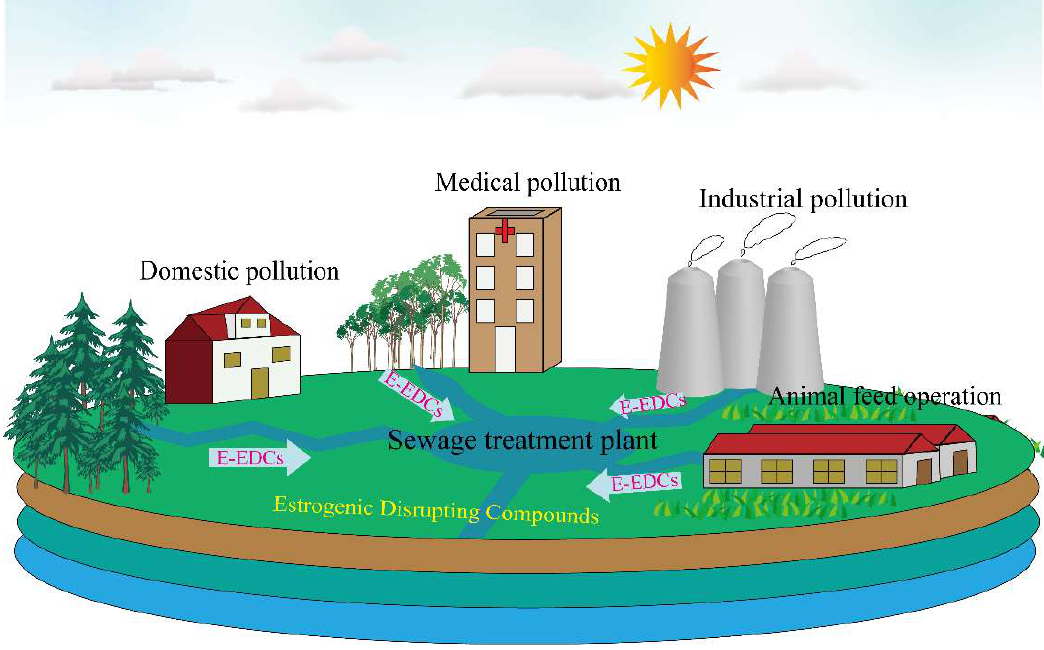
Figure 2. Sources of estrogen disrupting chemicals in environment.